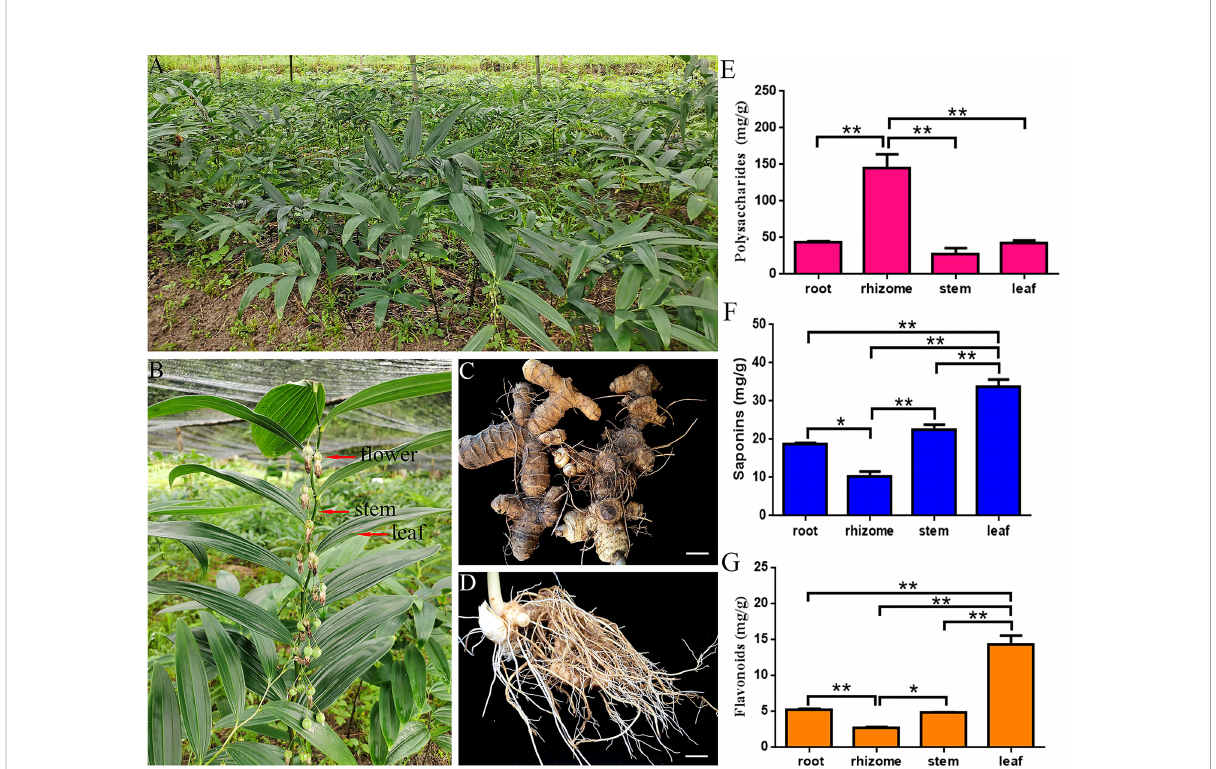
FIGURE 1 Representative photographs and physiological-biochemical indices of P. cyrtonema. (A) Mature P. cyrtonema in its natural habitat. (B) Flower, stems, and leaves. (C) Rhizome. (D) Root. (E) Total polysaccharides content. (F) Total saponins content. (G) Total fl avonoids content. Bars = 1 cm. “ ** ” and “ * ” represent signi fi cance at the 0.01 and 0.05 level,